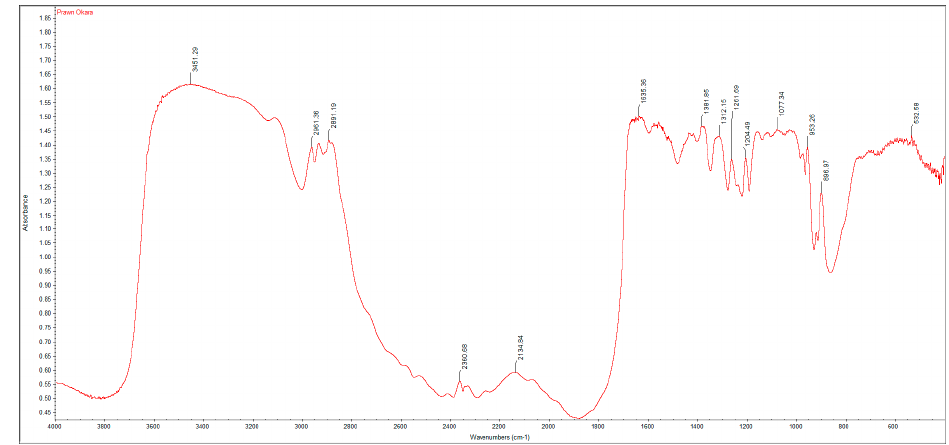
Figure 1. FTIR spectra of crustacean chitin extracted after fermentation on okara.